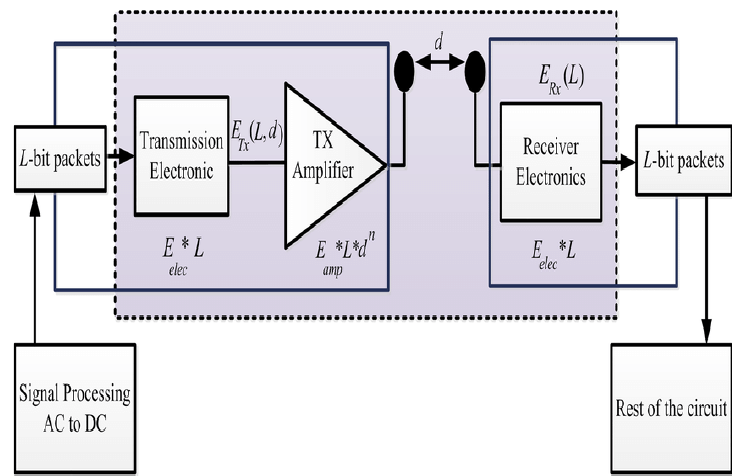
Figure 2. Radio energy